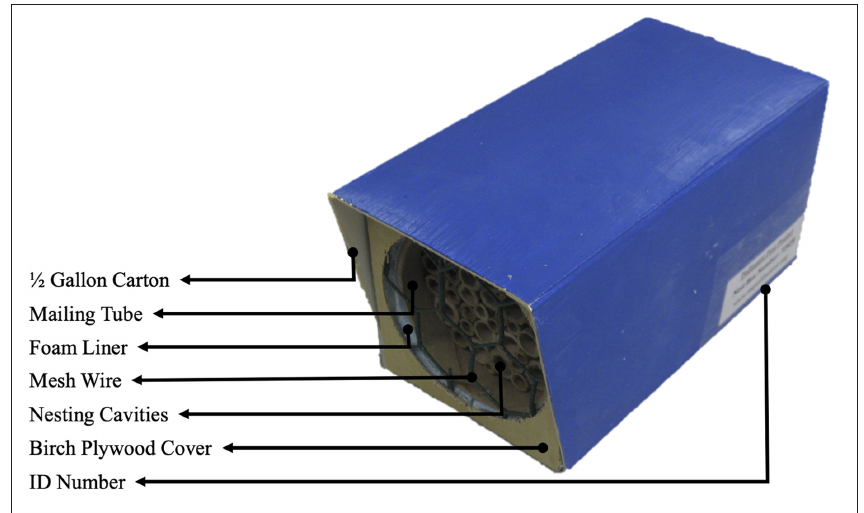
Figure 2: Nest box given to citizen scientists to record habitat preferences of wild bee pollinators in urban